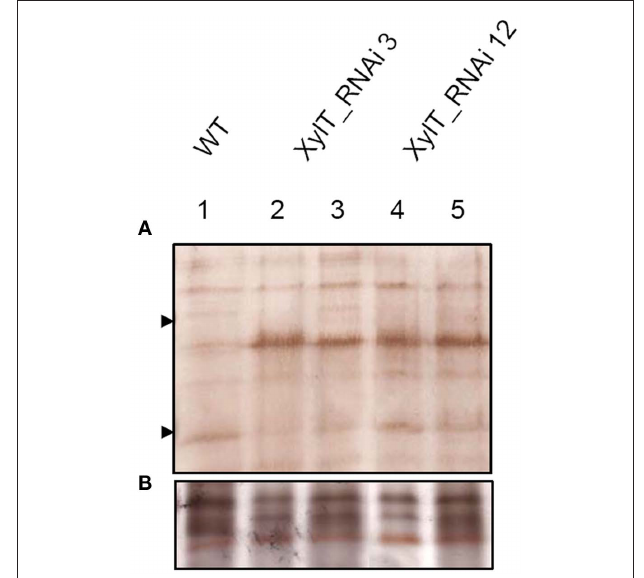
Figure 6 . For the IgE immunoblot analysis, protein extracts of WT ( Figure 6 , lane 1) and XylT_RNAi lines 3 ( Figure 6 , lane 2),